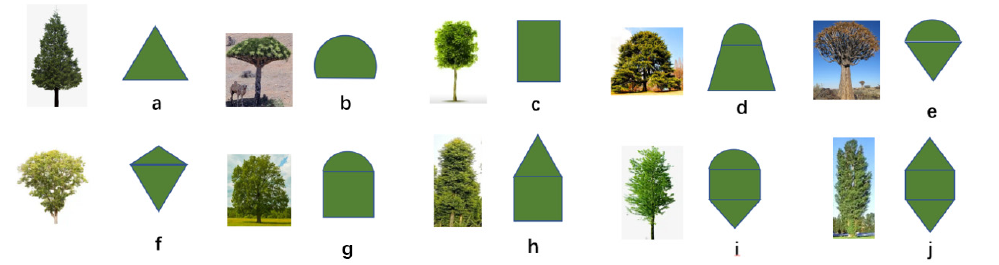
Figure 10. The profile shapes of the tree crowns. ( a ) triangle. ( b ) sector. ( c )rectangle. ( d ) The combination of sector and trapezoid from top to bottom. ( e ) The combination of sector and triangle from top to bottom. ( f ) The combination of two triangles from top to bottom. ( g ) The combination of sector and rectangle from top to bottom. ( h ) The combination of triangle and rectangle from top to bottom. ( i ) The combination of sector, rectangle and triangle from top to bottom. ( j ) The combination of triangle, rectangle and triangle from top to bottom.